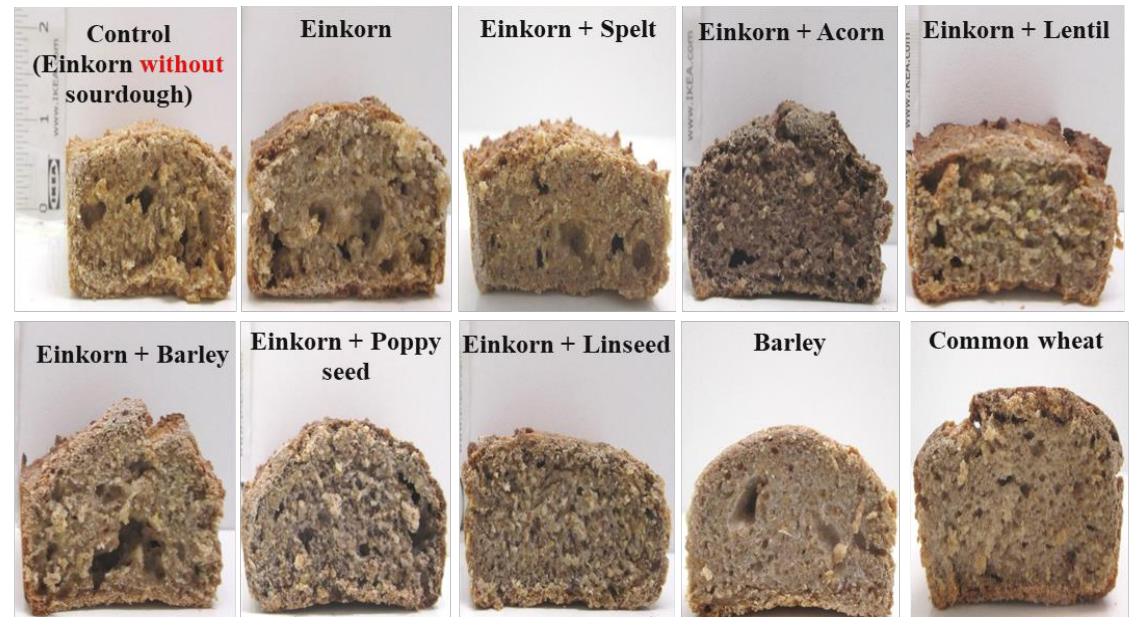
Figure 6. Appearance of a cross-section of breads; all breads made with sourdough except control; notation of samples as in Table 1.